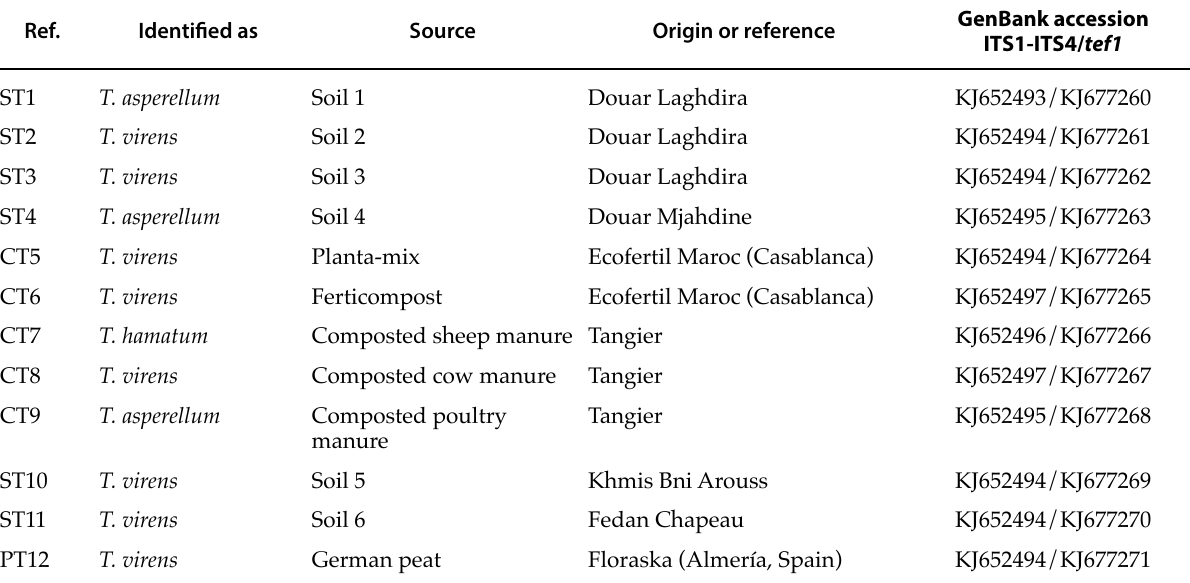
Table 3. Sources and accession numbers of Trichoderma strains isolated in this research.